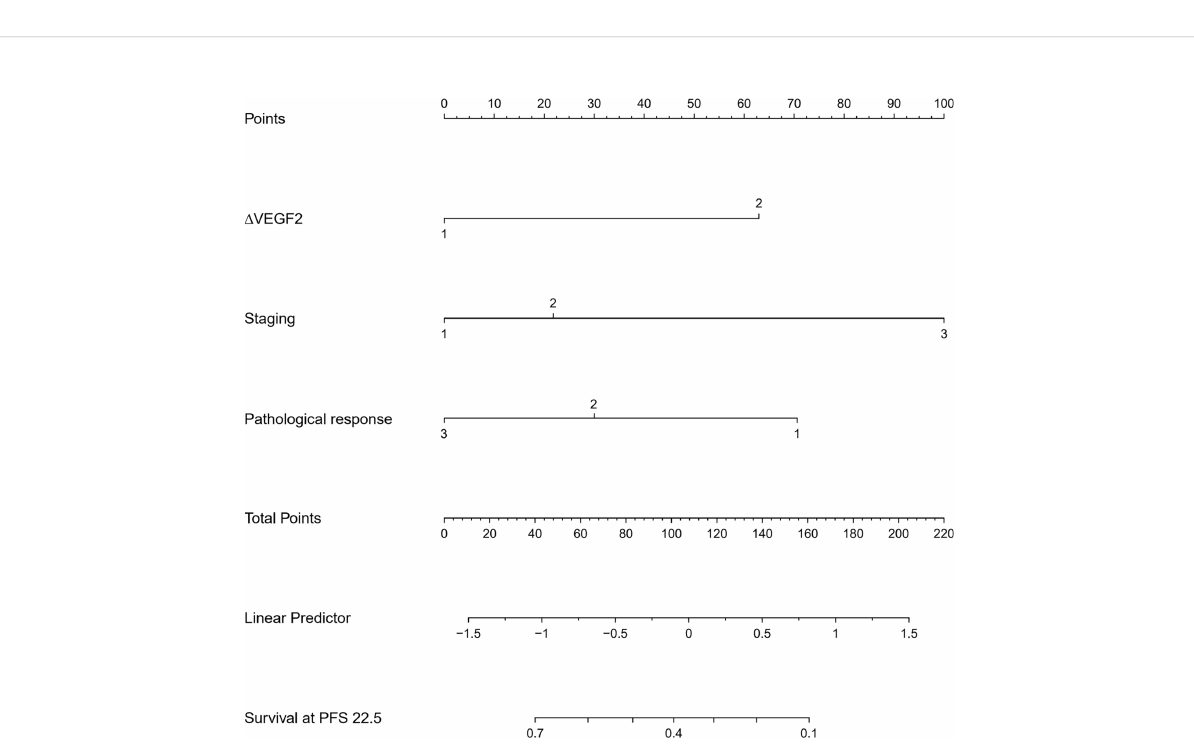
FIGURE 7 The nomogram for predicting the progression-free survival of patients with non-surgical